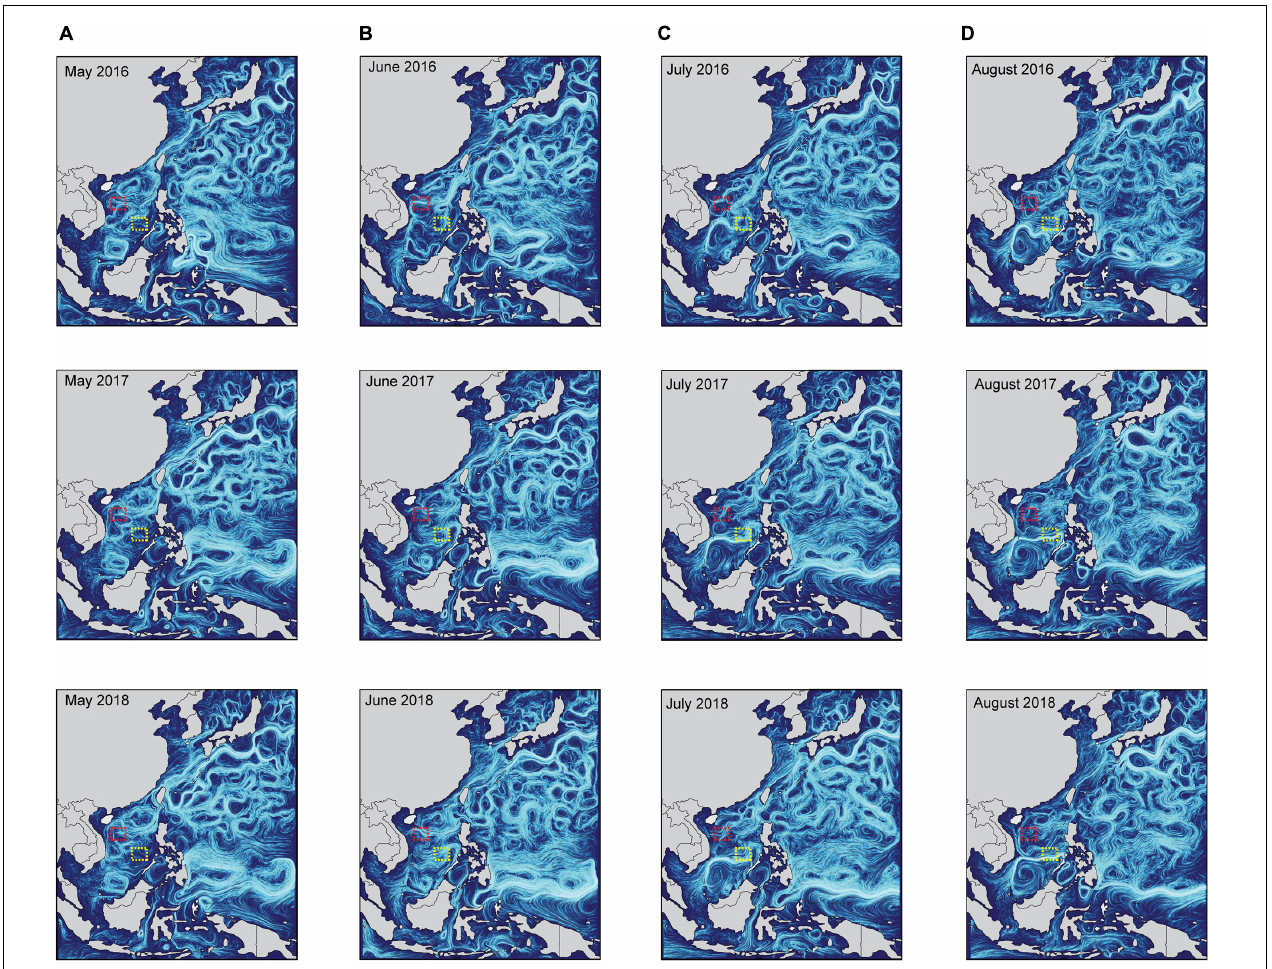
FIGURE 7 | The characteristics of ocean currents from 2016 to 2018 in the South China Sea. The upper-ocean surface current condition (depth < 2.5 m) in (A) May, (B) June, (C) July, and (D) August, which during potential crown-of-thorns starfish breeding periods in the Northern Hemisphere. These data were collected from the National Marine Science Data Center, National Science & Technology Resource Sharing Service Platform of China (http://mds.nmdis.org.cn/). Red and yellow dotted boxes contain sampling sites in the Paracel and Spratly Islands,